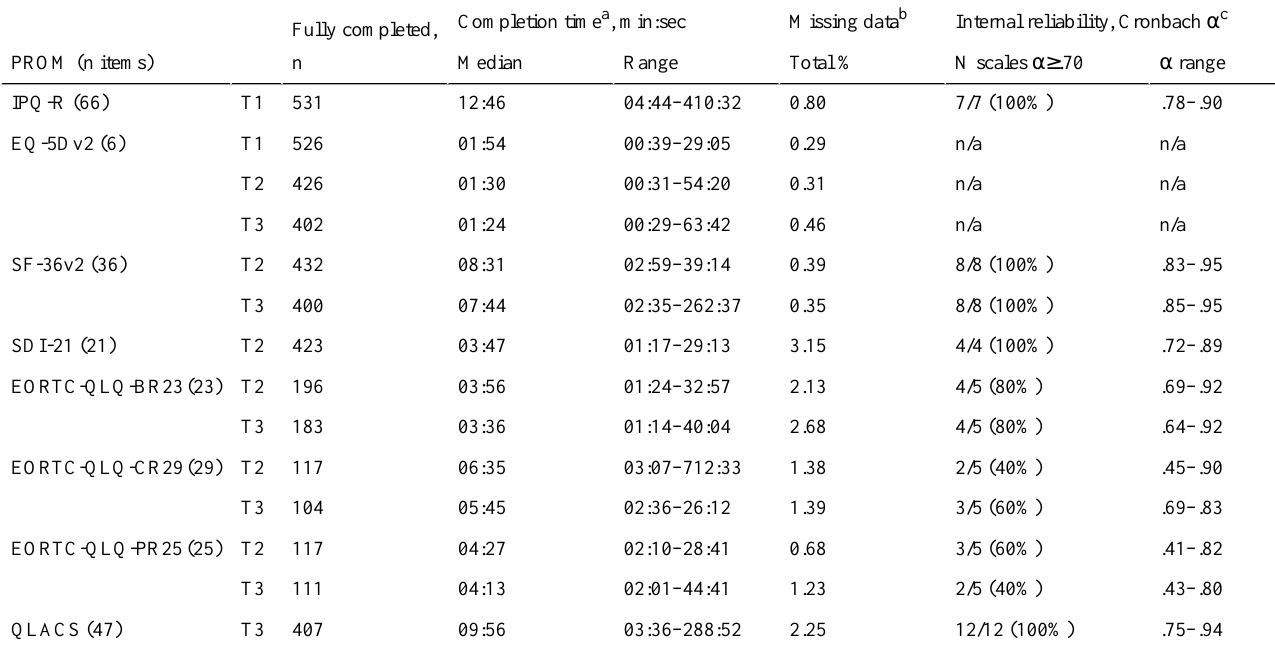
Table 3. Time to complete, missing data, and psychometric reliability for standard validated ePOCS PROMs (in addition to the standard validated PROMs shown here, participants also completed other questions, eg, about sociodemographic information, employment, and the financial costs of